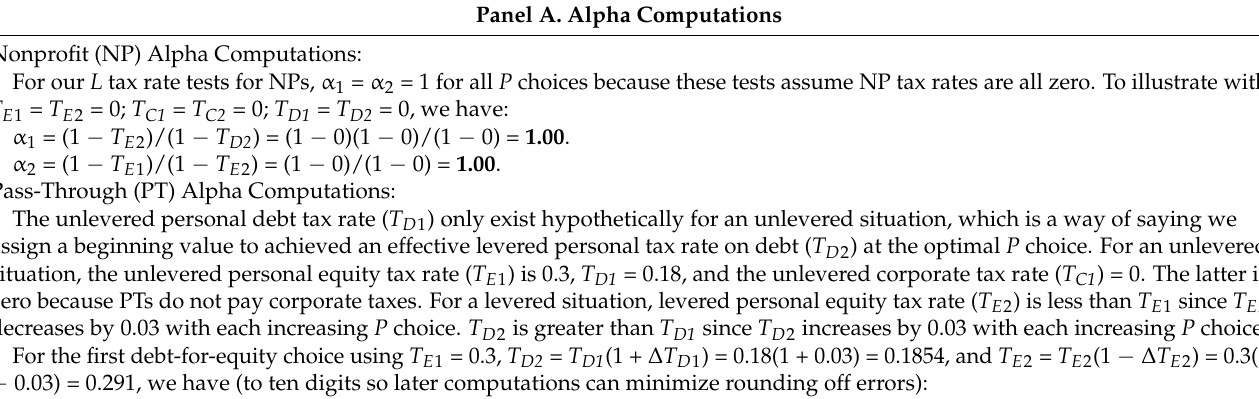
Table 2. Introductory Variables and Computations. Panel A. Alpha